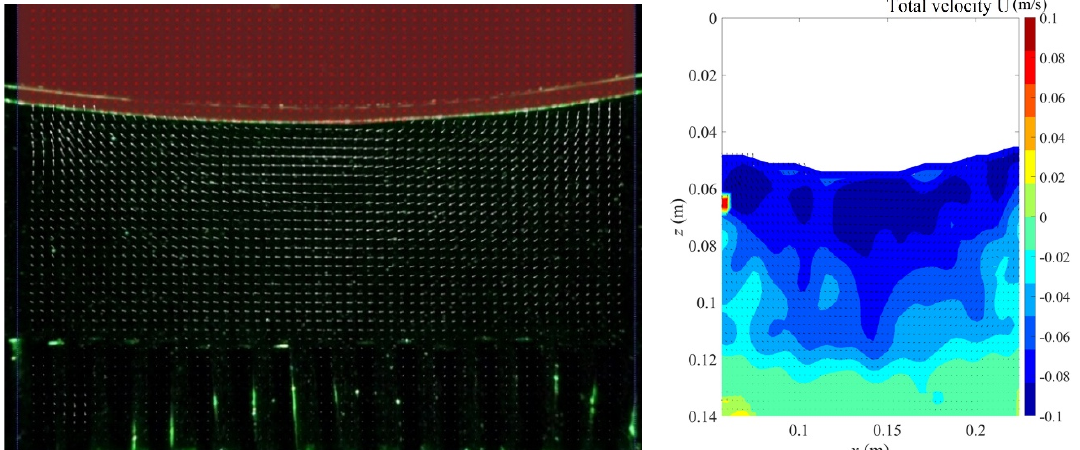
Figure 14. Velocity field and distribution of a short-period wave trough ( T = 0.5 s) passing through vegetation structures ( ϕ = 0.5 cm and d = 5 cm).